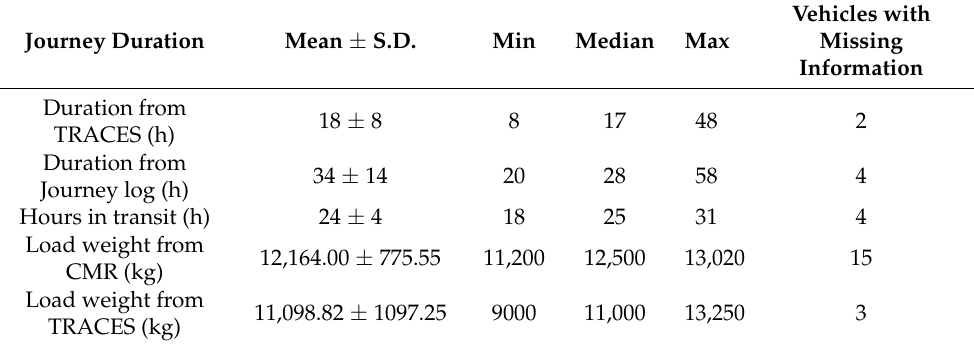
Table 7. Descriptive statistics for the journey durations and load weight observed from the documen- tation of the 20 journeys of unbroken horses towards a Southern Italy